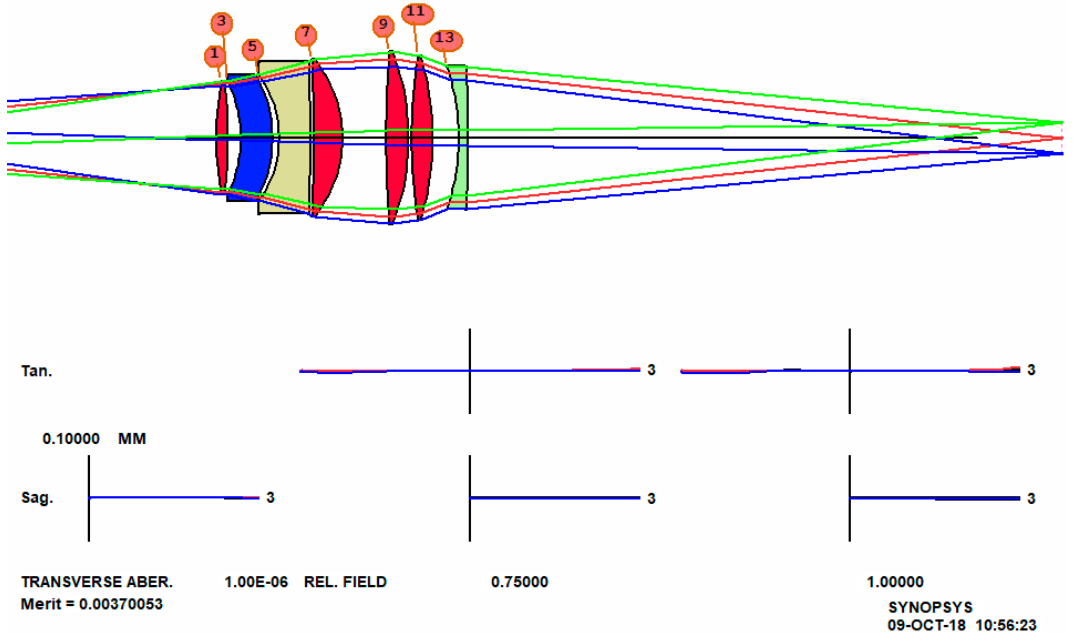
Figure 4. Final design for the double-Gauss problem, with real glass replacing the glass models.